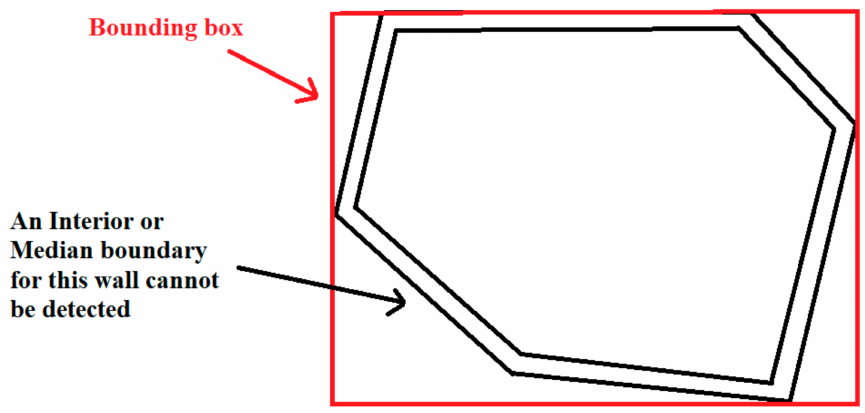
Figure 17. Errors that may occur in the analysis using the 3D bounding box of legal